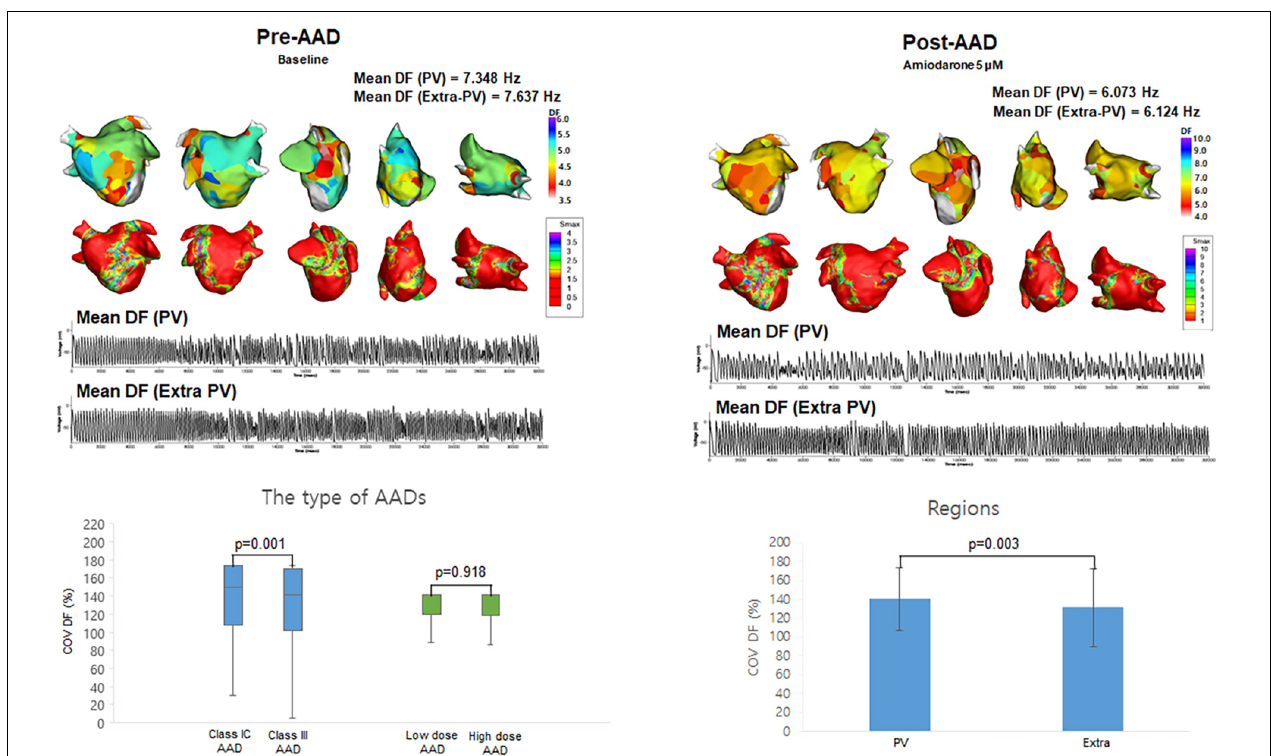
FIGURE 2 | The effects of antiarrhythmic drugs (AADs) on extra-PV and pulmonary vein (PV) regions. The 3D dominant frequency (DF) map indicated that the mean DF was higher in the PV regions. Electrograms demonstrated regional voltage changes in PV and extra-PV areas. Coefficient of Variation-Dominant Frequency (COV-DF) was higher in class IC and PV